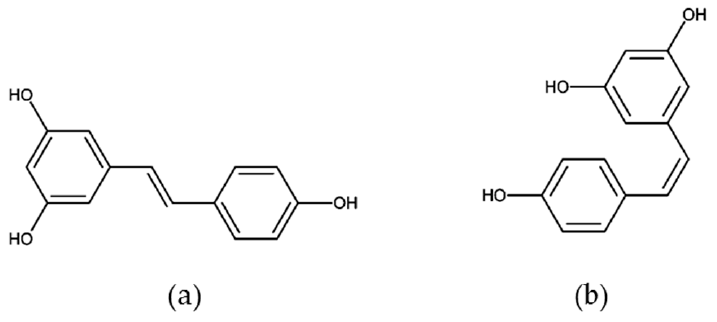
Figure 5. Structures of stilbenes. ( a ) Trans- resveratrol and ( b ) cis-resveratrol.